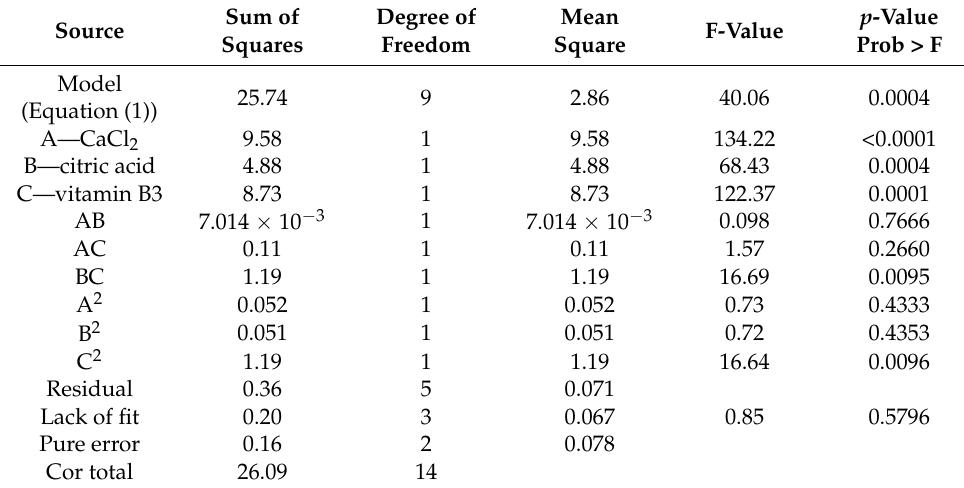
Standard deviation = 0.27, mean = 4.03, coefficient of variation = 6.63%, predicted residual sum of squares = 3.56, R 2 = 0.9863, adjusted R 2 = 0.9617, predicted R 2 = 0.8637, and adequate precision =